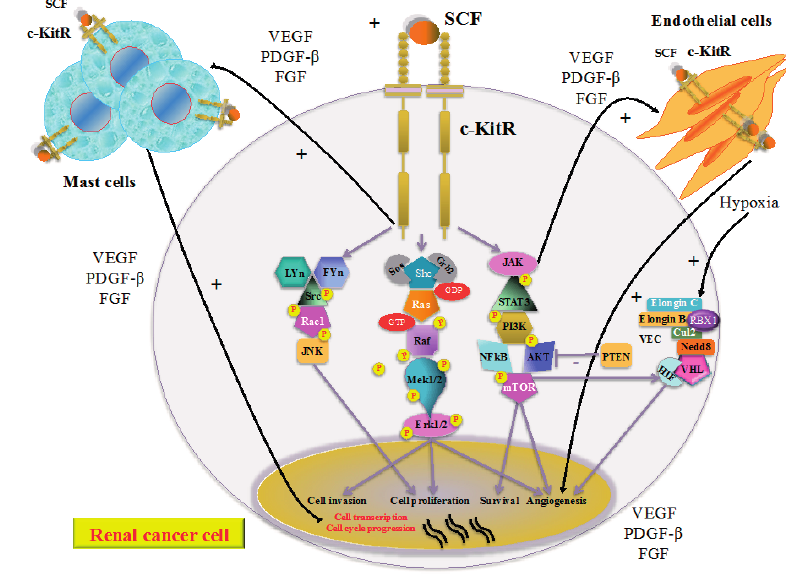
Figure 1. In renal cancer cells, stem cell factor (SCF) binding to the c-Kit receptor (c-KitR) induces several signal transduction pathways that lead to its proliferation, invasion, survival, and angiogenesis. Moreover, the increased activation of the c-KitR pathway leads to the activation of MC, which secretes pro-angiogenic cytokines (VEGF, PDGF- β , FGF) and induces cross-talk between MC, renal cancer cells and endothelial cells leading to the consequential strengthening of pro-angiogenic signaling,. In addition, hypoxia induces HIF to stimulate the transcription of genes that lead to the secretion of pro-angiogenic factors. Abbreviations: c-KitR, c-Kit receptor; SCF, stem cell factor, VEGF, vascular endothelial growth factor; PDGF- β , platelet derived growth factor- β ; FGF, Fibroblast Growth Factor; LYn , Lck/Yes -related protein kinase; FYn , FYn oncogene related to SRC, FGR, YES; Src , V- Src sarcoma (Schmidt-Ruppin A-2) viral oncogene homolog; Rac1, Ras-related C3 botulinum toxin substrate 1; JNK , c - Jun N -terminal kinase JNK ; Sos, son of sevenless; Grb2, growth factor receptor-bound protein 2; Shc, SHC-adaptor protein; Ras, rat sarcoma protein; Raf , RAF proto-oncogene serine/threonine-protein kinase; Mek1/2, MAP kinase-ERK kinase; Erk1/2, Elk-related tyrosine kinase; JAK, Janus kinase; STAT3, signal transducer and activator of transcription 3; PI3K, phosphatidyl inositol 3-kinase; NF- κ B, nuclear factor kappa B; AKT, protein kinase B; mTOR, mammalian target of rapamycin; PTEN, phosphatase and TEnsiN homolog; VHL,von Hippel-Lindau protein; Cul2, cullin2; Nedd8, neural precursor cell expressed developmentally down-regulated 8; RBX1, ring-box 1; VEC, E3 ubiquitin ligase complex; HIF, hypoxia-inducible